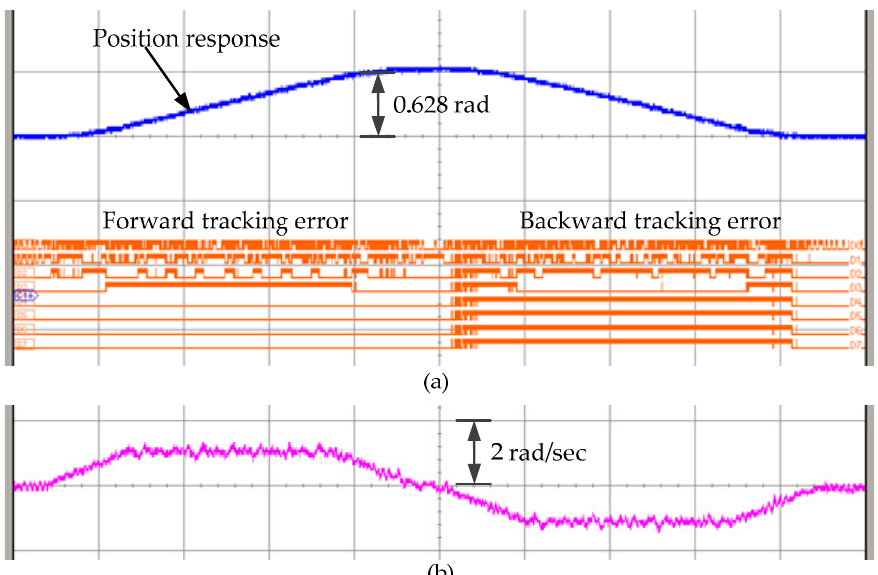
Figure 20. The responses of run forward and backward with trapezoidal velocity profile. ( a ) position and position tracking error; ( b ) speed.